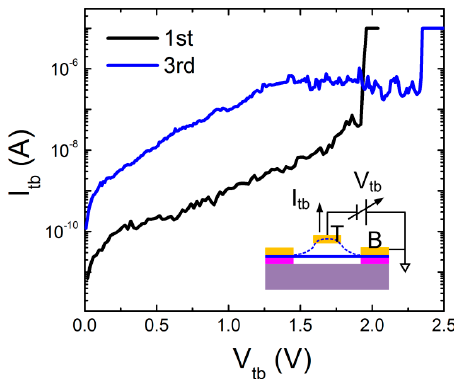
Figure 4. Electrical characterization of the switching performance of a double-clamped beam switch. The inset shows the two-terminal measurement configuration.